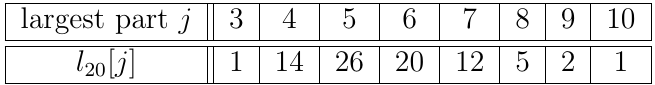
Table 10: Number l [ j ] of forcibly connected graphical partitions of 20 with given largest 20 term j .